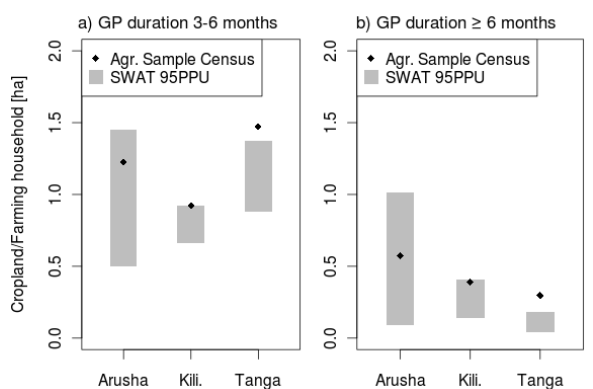
uncertainty boundary (U95PPU).